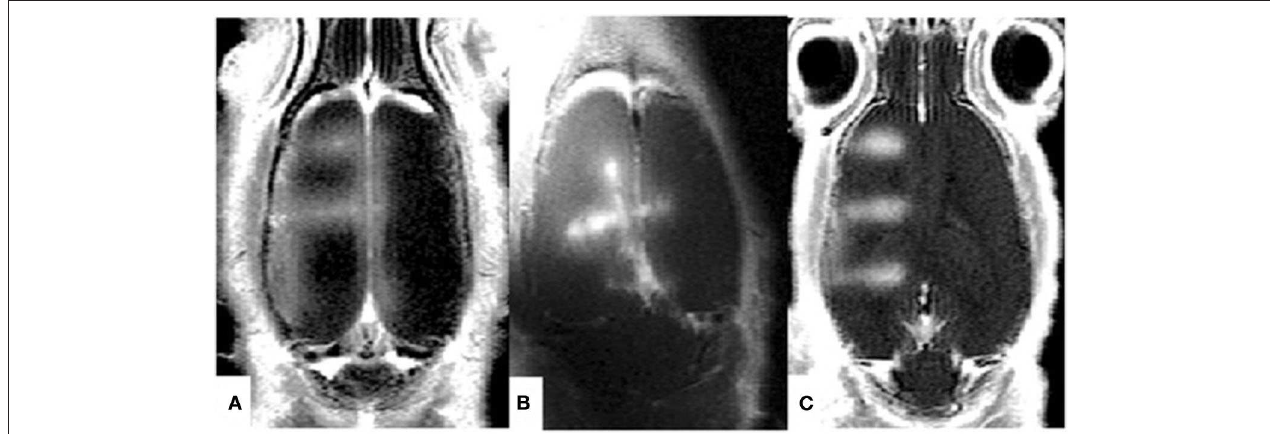
FIGURE 2 | Contrast Agent enhanced MRI images obtained after MRgFUS-induced BBB opening in rats. Thanks to the MRI guidance, BBB disruption has been performed along different trajectories [ (A–C) in the figure]. Reproduced with permission from